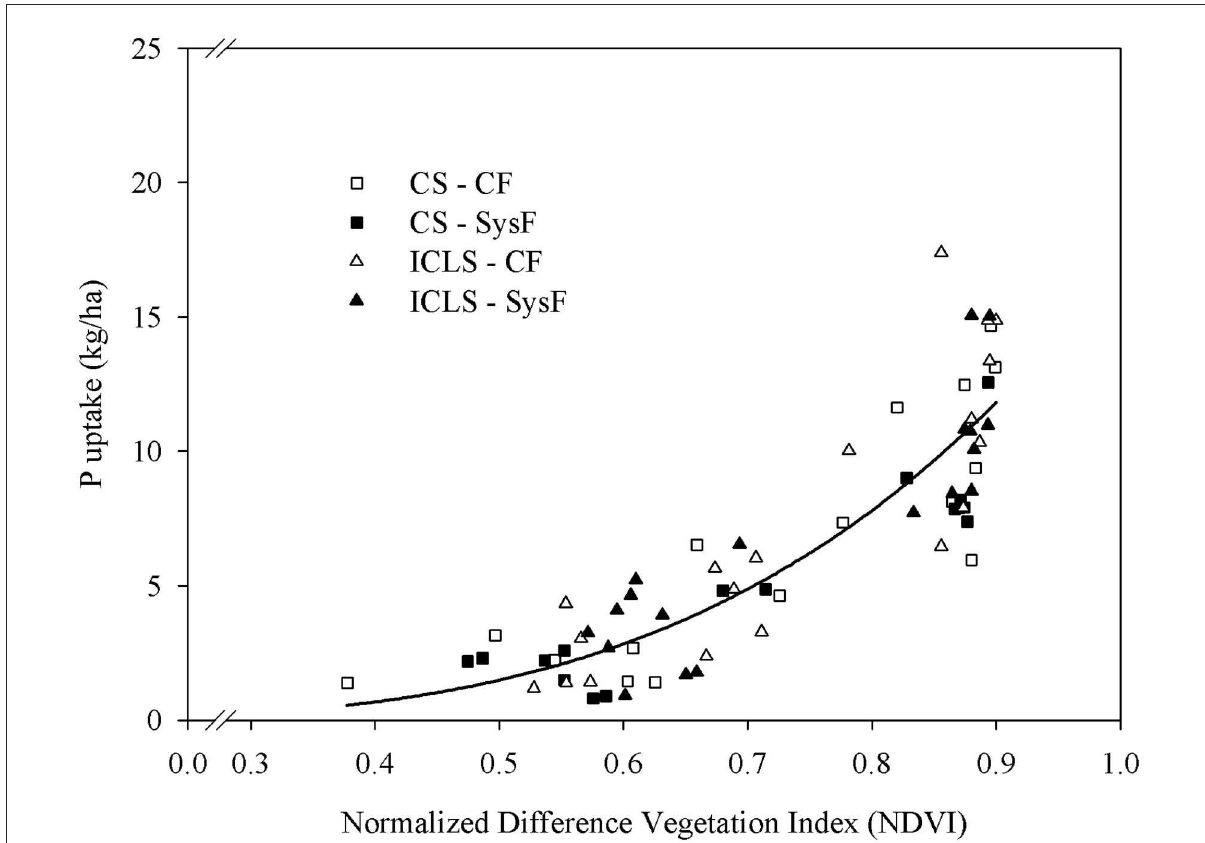
FIGURE5 Relationship between phosphorus (P) uptake and the Normalized Difference Vegetation Index under the cropping system with crop fertilization (CS–CF), the cropping system with system fertilization (CS–SysF), the integrated crop-livestock system with crop fertilization (ICLS–CF), or the integrated crop-livestock system with system fertilization